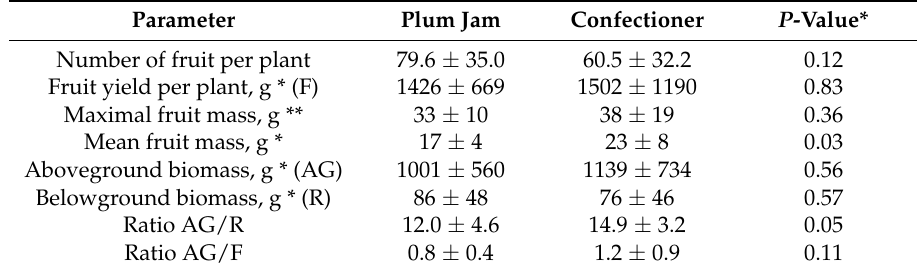
Table 3. Some characteristics of husk tomato production averaged over five experimental sites (mean ± standard deviation). Parameter Plum Jam